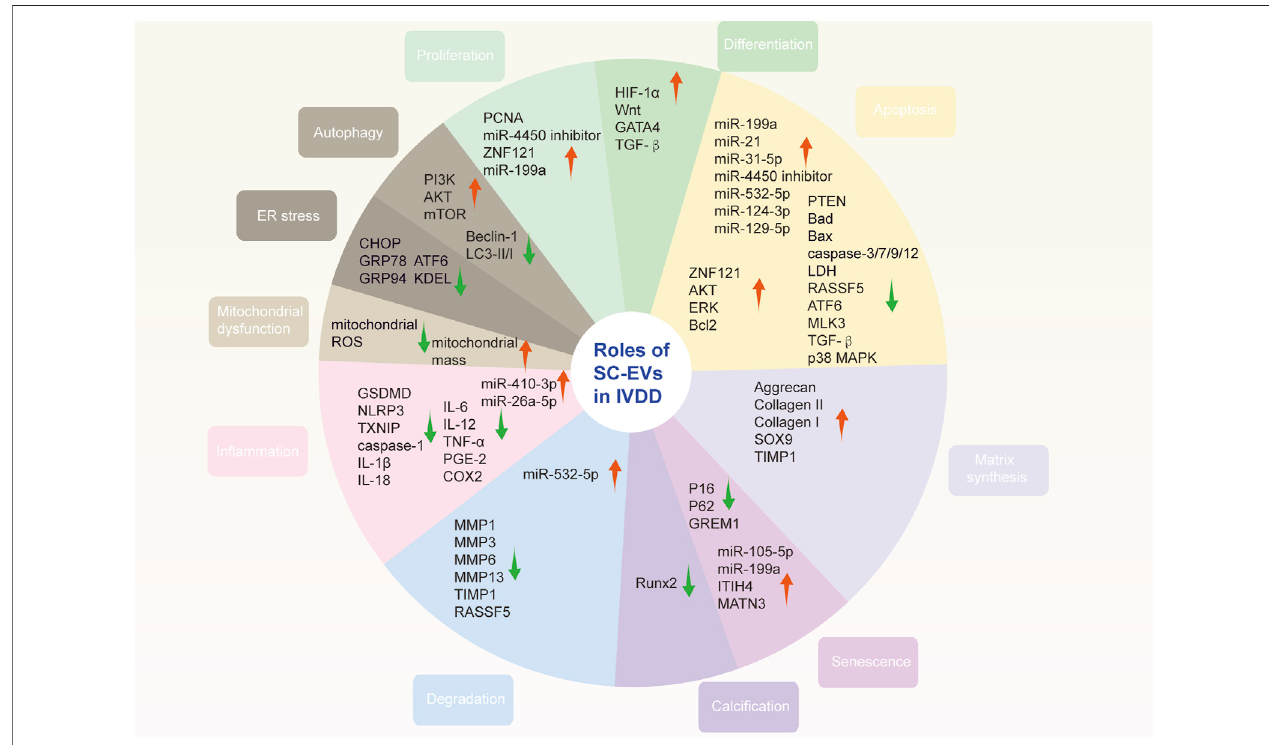
FIGURE 3 | Roles of stem cell-derived extracellular vesicles in intervertebral disc degeneration. SC-EVs ameliorate IVDD via suppressing apoptosis and senescenceaswellaspromotingproliferation.TheyalsopromoteECMsynthesisandinhibitdegradation.Inaddition,oxidativestressandin fl ammationarereducedafter SC-EVs delivered. Note: red arrow, upregulated; green arrow, downregulated; SC-EVs, stem cell-derived extracellular vesicles; IVDD, intervertebral disc degeneration; ECM, extracellular matrix.